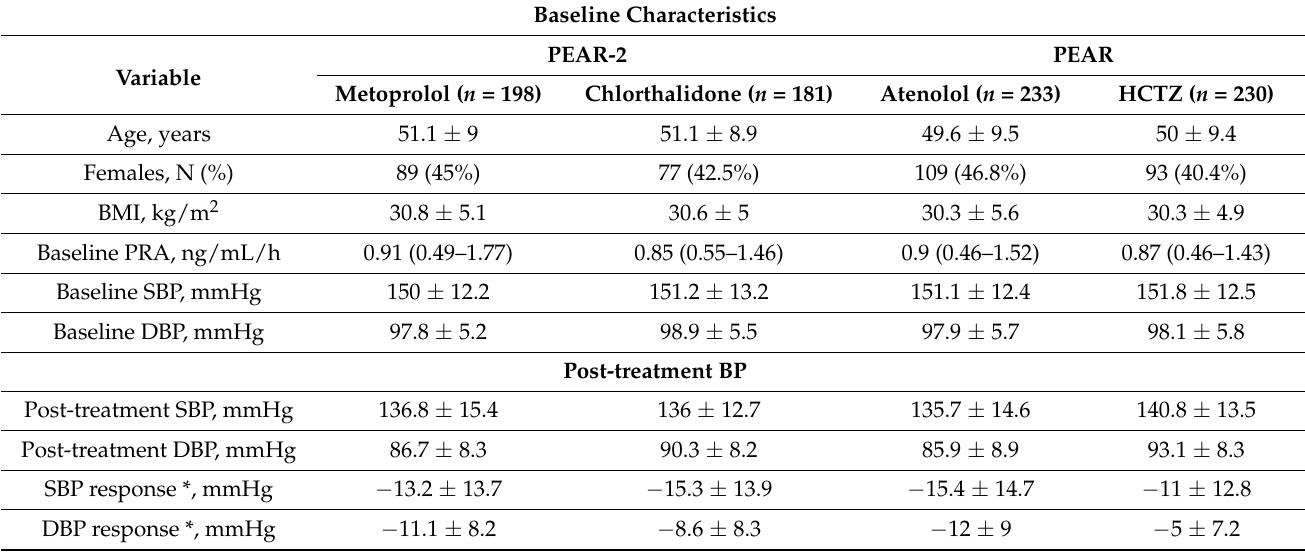
Table 1. Characteristics of the European American participants included in PEAR-2 and PEAR studies.